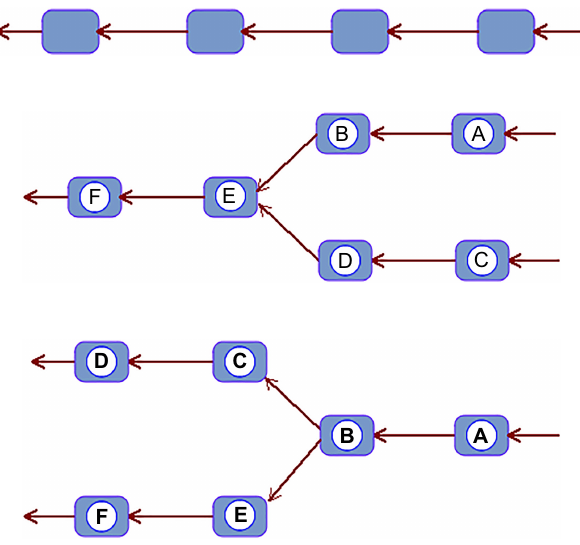
Figure 8. Asimplelinearpipeline